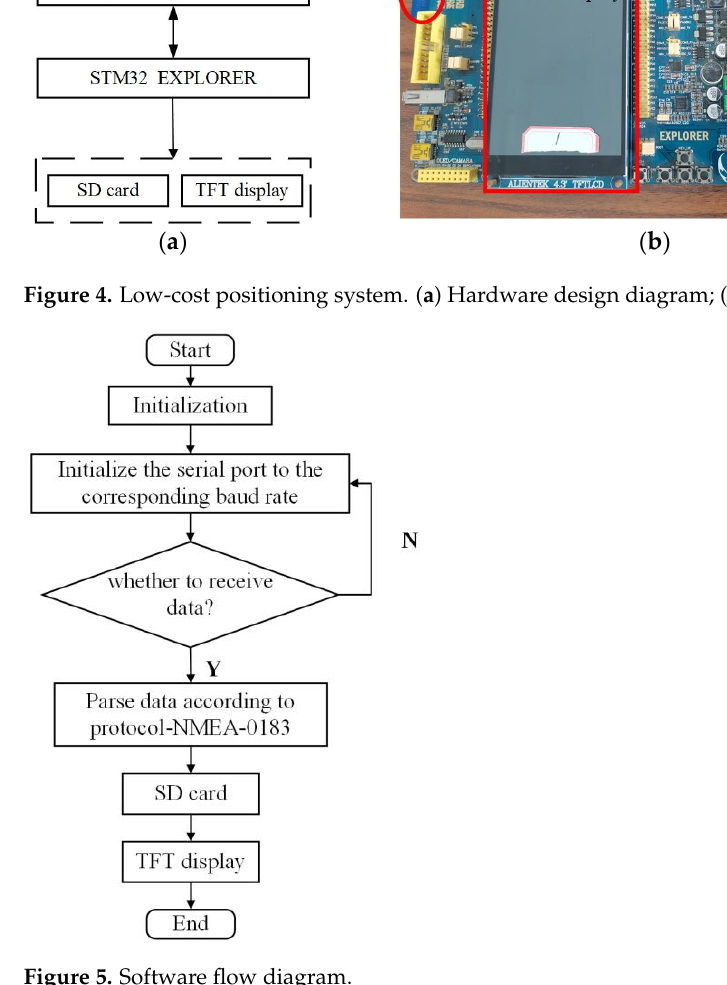
Figure 5. Software flow